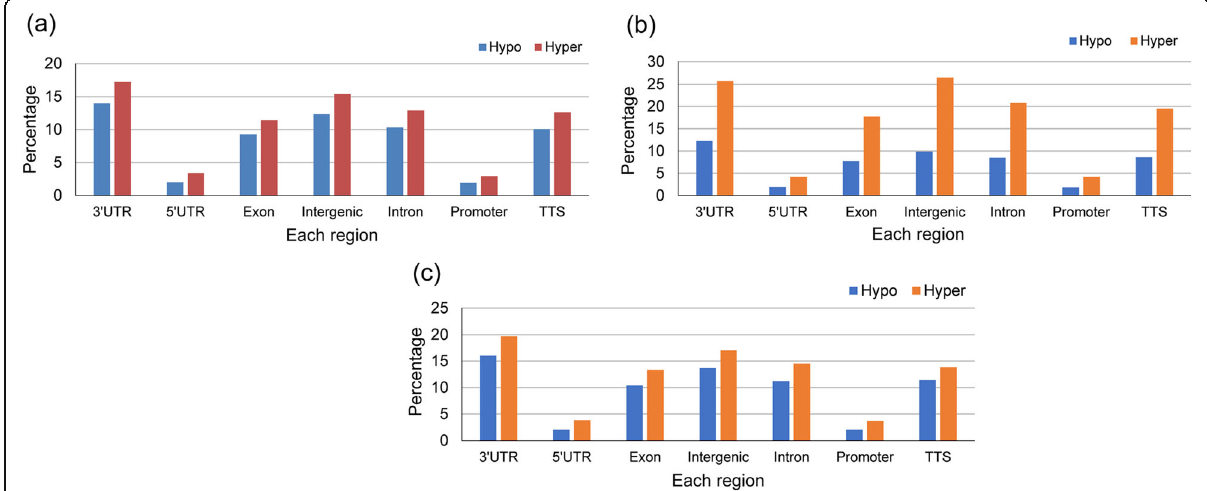
Fig. 5 Percentage of CpGs in the elevated methylation group and depressed methylation group compared with NoAA group is shown per region. (> 25% elevated: hypermethylation group; > 25% reduced: hypomethylation group). a EAA; b NEAA; c AllAA; CpG: 5 ′– C – phosphate – G – 3